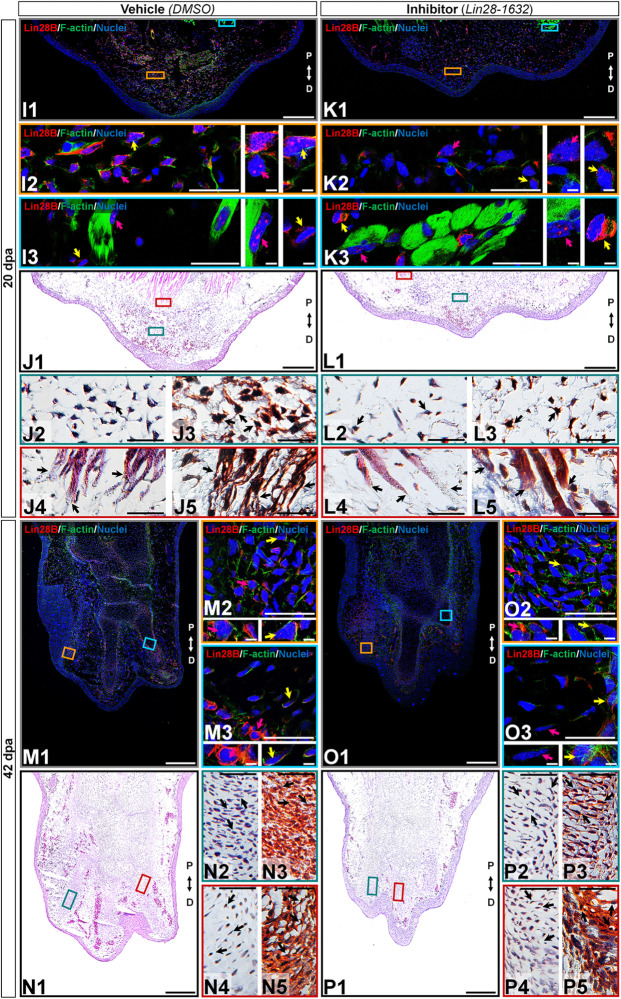
Histological changes after functional inhibition of Lin28 in key regeneration stages (continuation). (K,L,O,P) Histological sections of limbs treated with Lin28-1632 inhibitor, oriented in the Proximal-Distal axis. (I,J,M,N) Histological sections of limbs treated with vehicle, oriented in the Proximal-Distal axis. (I–L) Medium blastema stage (20 dpa). (M–P) Late palette–early digits stage (42 dpa). (I1,K1,M1,O1) Subcellular localization of amxLin28B marked in red, by contrast with DAPI (blue) and Phalloidin (green). Scale bars: 500 μm. (I2-3,K2-3,M2-3,O2-3) Magnifications with different color contours to remark some areas of interest for amxLin28B in red, DAPI in blue, and Phalloidin in green; arrows in yellow and magenta have in turn their own zoom in. Scale bars: 50 and 5 μm, respectively. (J1,L1,N1,P1) General tissue morphology shown with Hematoxylin and Eosin staining. Scale bars: 500 μm. (J2/4,L2/4,N2/4,P2/4) Magnifications with distinct color contours to indicate some areas of interest in Hematoxylin and Eosin staining. Scale bars: 50 μm. (J3/5,L3/5,N3/5,P3/5) Differential staining to view changes on stroma for similar zones indicated in H&E ampliations. Scale bars: 50 μm. The distinct arrows point to diverse tissue components, as described in the results.